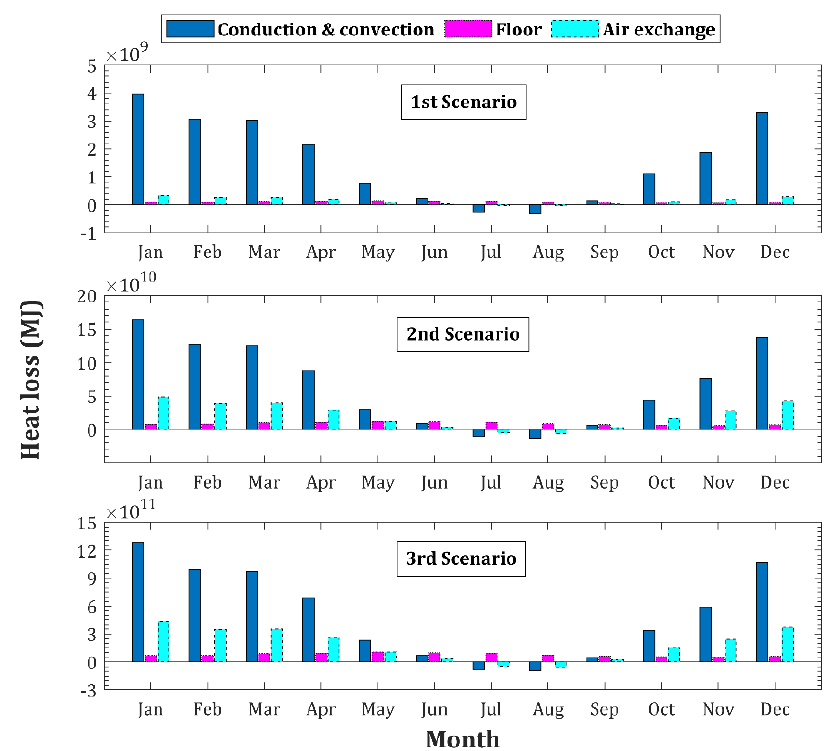
Figure 13. Monthly values of heating losses through the conduction, convection, and air exchange in the greenhouses.